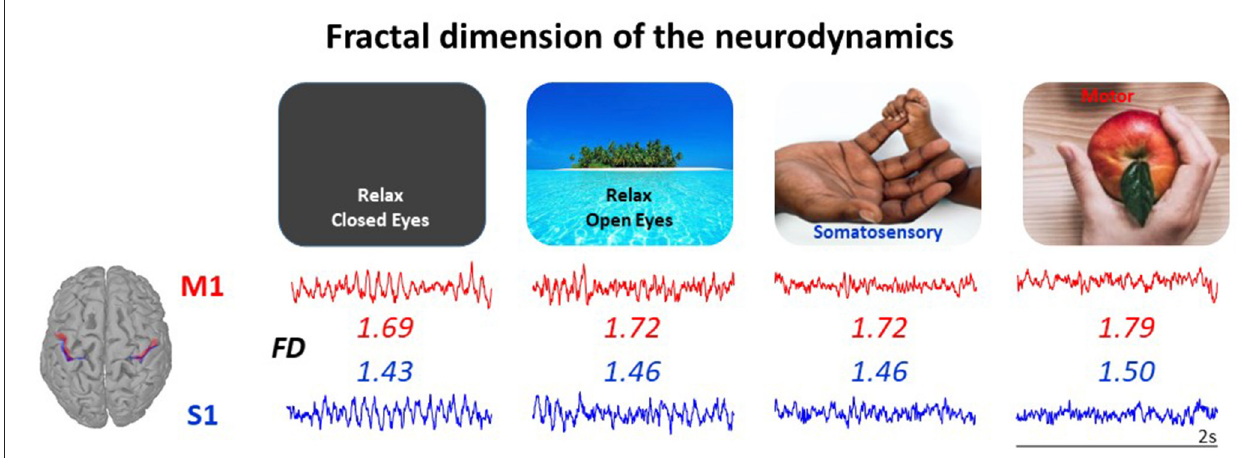
FIGURE 1 | The neurodynamics complexity measured via its fractal dimension (FD) is a single number enabling to characterize the state of a neuronal network node, even at rest. FD of the neurodynamics (2 s in each state) increases when passing from relax in absence of any stimuli (Left) to selective sensory perception, to active sensorimotor control (Right) . The FD of a node mirrors its structural specificity: here, the primary somatosensory hand area (S1, blue) has smaller FD than primary motor hand area (M1, red) in all network states. Both the state-dependency and the cortical district-dependency are statistically significant in the 20 healthy volunteers’ population, as reported in Cottone et al. (2017), where the data come from.